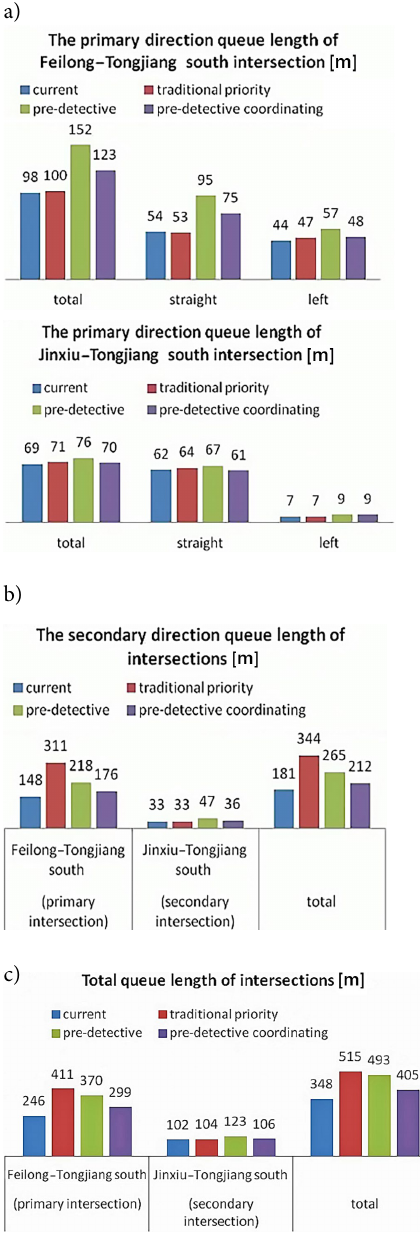
Fig. 5. Queue lengths of intersections: a – primary